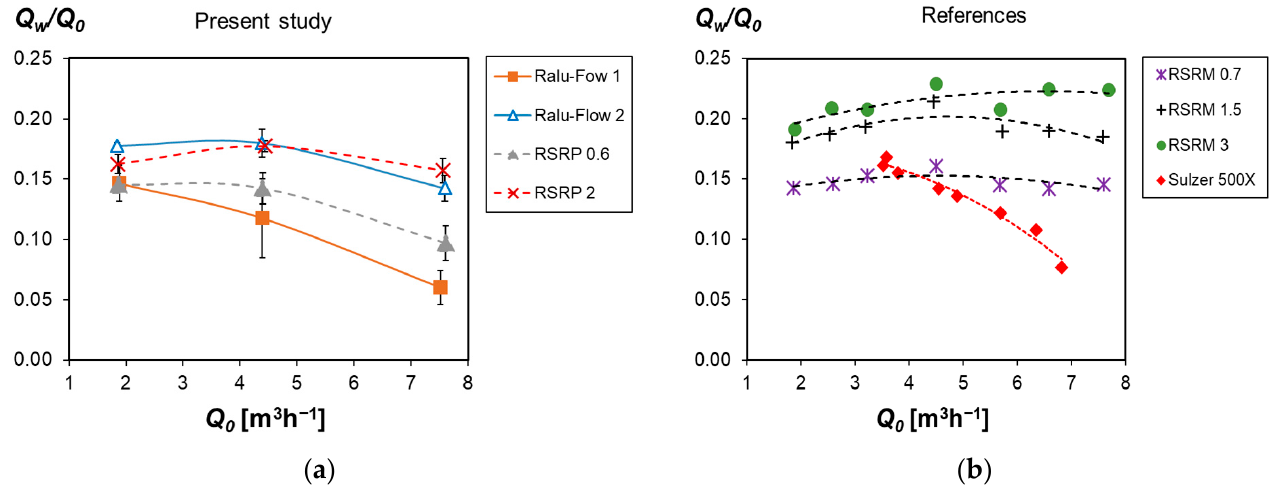
Figure 6. Relative wall flow rate in uniform initial distribution: ( a ) Present study of Ralu–Flow and plastic Raschig Super–Ring; ( b ) References: Metal Raschig Super–Ring [41] and Sulzer 500X [12].